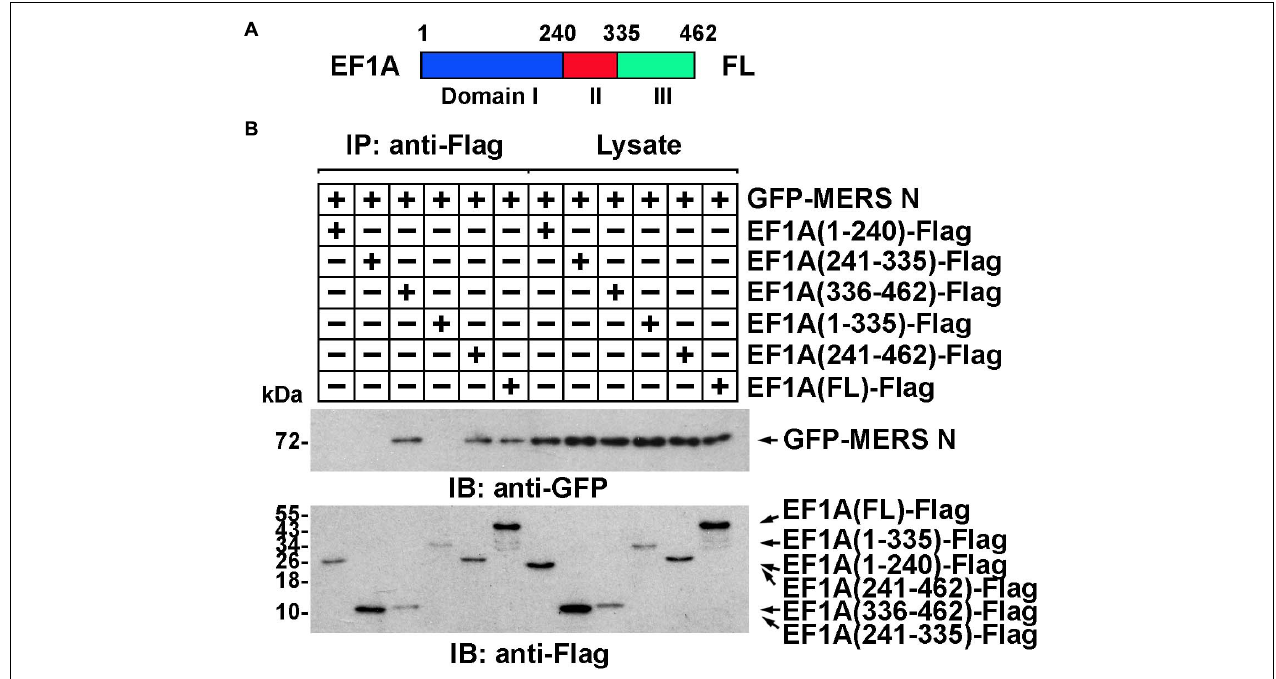
FIGURE 3 | The interaction between EF1A and the MERS-CoV N protein primarily depends on the third (C-terminal) domain of EF1A. (A) Schematic representation of eEF1A protein domains. (B) Anti-Flag immunoprecipitates prepared from lysates of HEK293T cells expressing the GFP-MERS-CoV N protein and EF1A-Flag or mutants were assayed by immunoblotting. The GFP-tagged N protein, Flag-tagged EF1A, and mutants were detected with the indicated